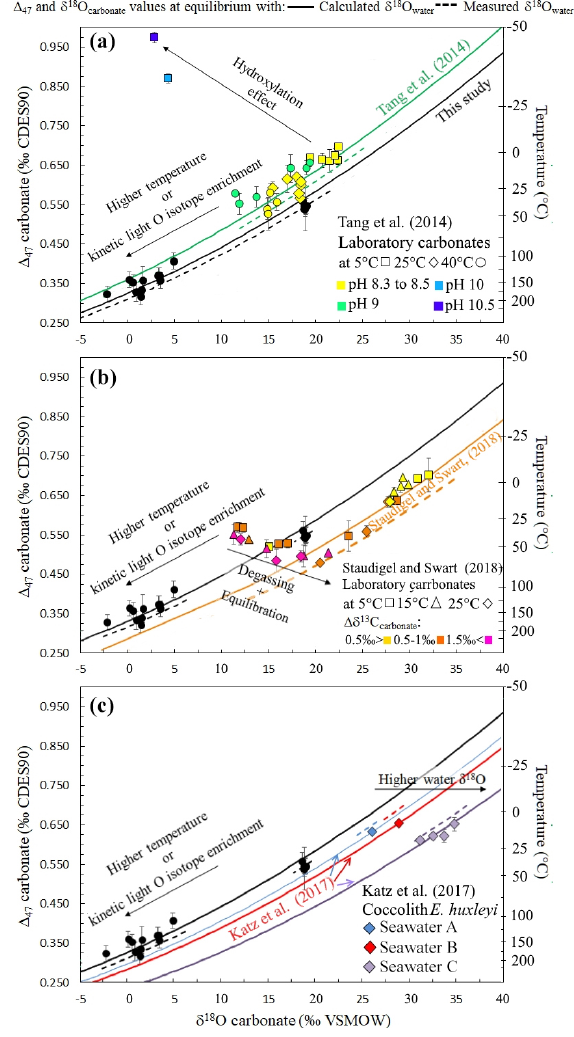
Figure 6. (cid:49) 47 and δ 18 O carbonate relationship to precipitation wa- ter δ 18 O water for other solid carbonates presenting oxygen isotope disequilibria. In (a) to (c) the black data series (this study, per- formed at 30 ◦ C) shows how kinetic oxygen isotope fractionation in the DIC prior to carbonate precipitation can be mistaken for high-temperature isotopic equilibrium. Similarly to Fig. 5, the solid curves were obtained using the δ 18 O water calculated with Eq. (2). (a) Abiotic carbonates from Tang et al. (2014) illustrating the effect of CO 2 hydroxylation on (cid:49) 47 and δ 18 O carbonate values (various pH values plotted with different colors, various temperatures plot- ted with different symbols). (b) Abiotic carbonates from Staudigel and Swart (2018) illustrating the effect of CO 2 degassing and DIC oxygen isotope equilibration with water on (cid:49) 47 and δ 18 O carbonate values. (cid:49)δ 13 C carbonate stands for the difference between the δ 13 C value measured in carbonates and the final δ 13 C of the data series at the end of equilibration (various (cid:49)δ 13 C ranges plotted with dif- ferent colors, various temperatures plotted with different symbols). (c) Coccolithophorid E. huxleyi grown at 7, 10, 15, 20 and 25 ◦ C from Katz et al. (2017) showing how coccoliths with equilibrium (cid:49) 47 values record the equilibrium δ 18 O water of their body water, which differs from that of the culture medium (i.e., artificial seawa- ters A, B and C plotted with different